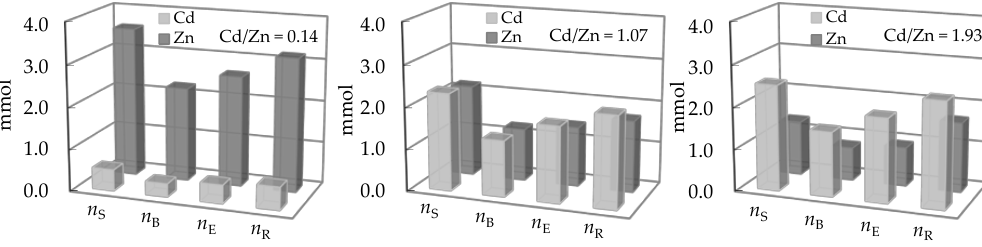
Figure 10. Comparison of n S , n B , n E , and n R for different Cd/Zn ratios in the feeding (Cd + Zn) solution.